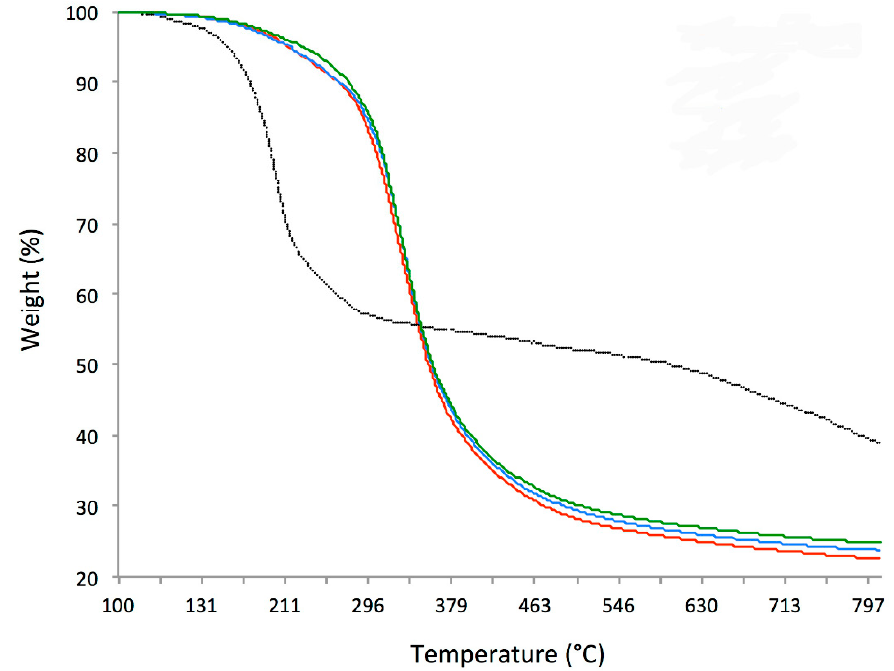
Figure 2. Thermo-gravimetric analyses (TGA) of graphene oxide (black curve), bare Lamina (red curve), 5 µg/mL GO enriched Lamina (blue curve) and Lamina enriched with 10 µg/mL GO (green curve).